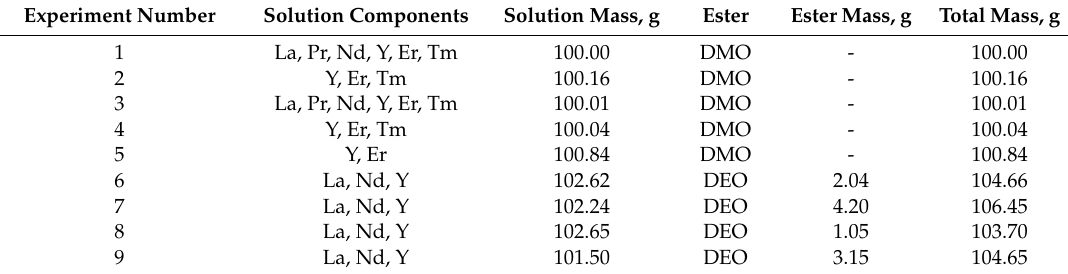
Table 1. Identity of solution components and masses for each